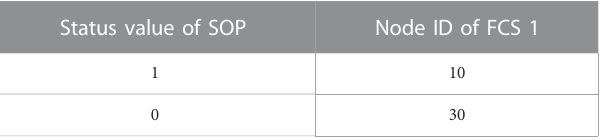
TABLE 4 SOP status